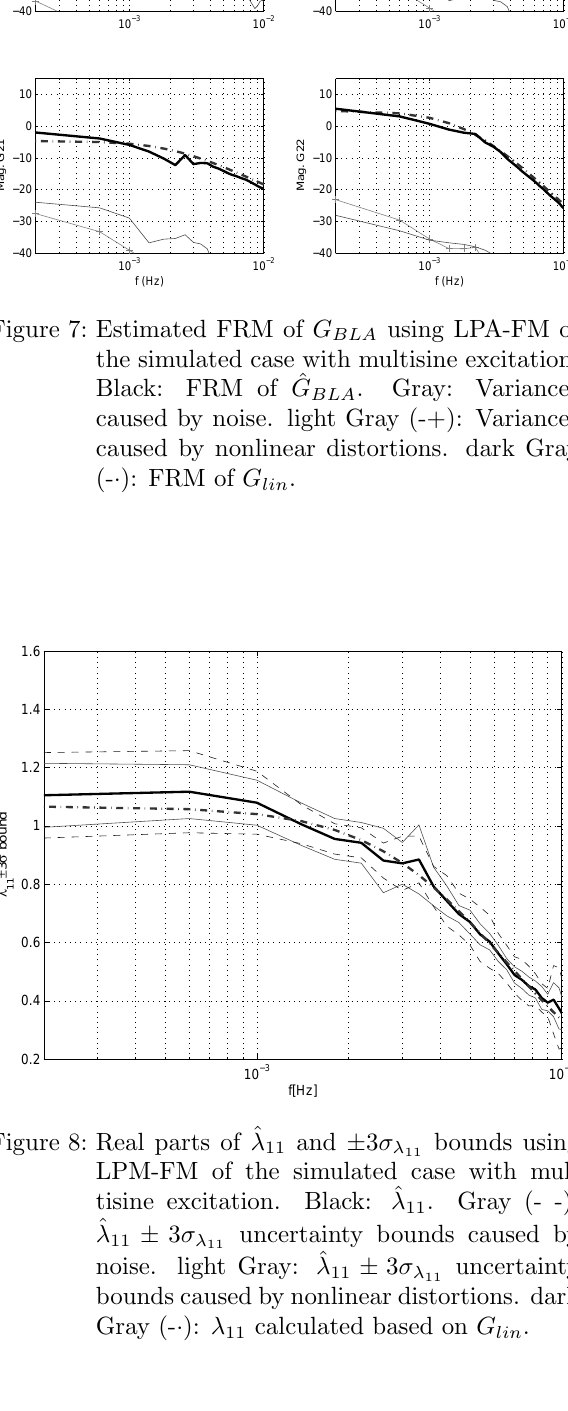
bounds using 11 uncertainty 11